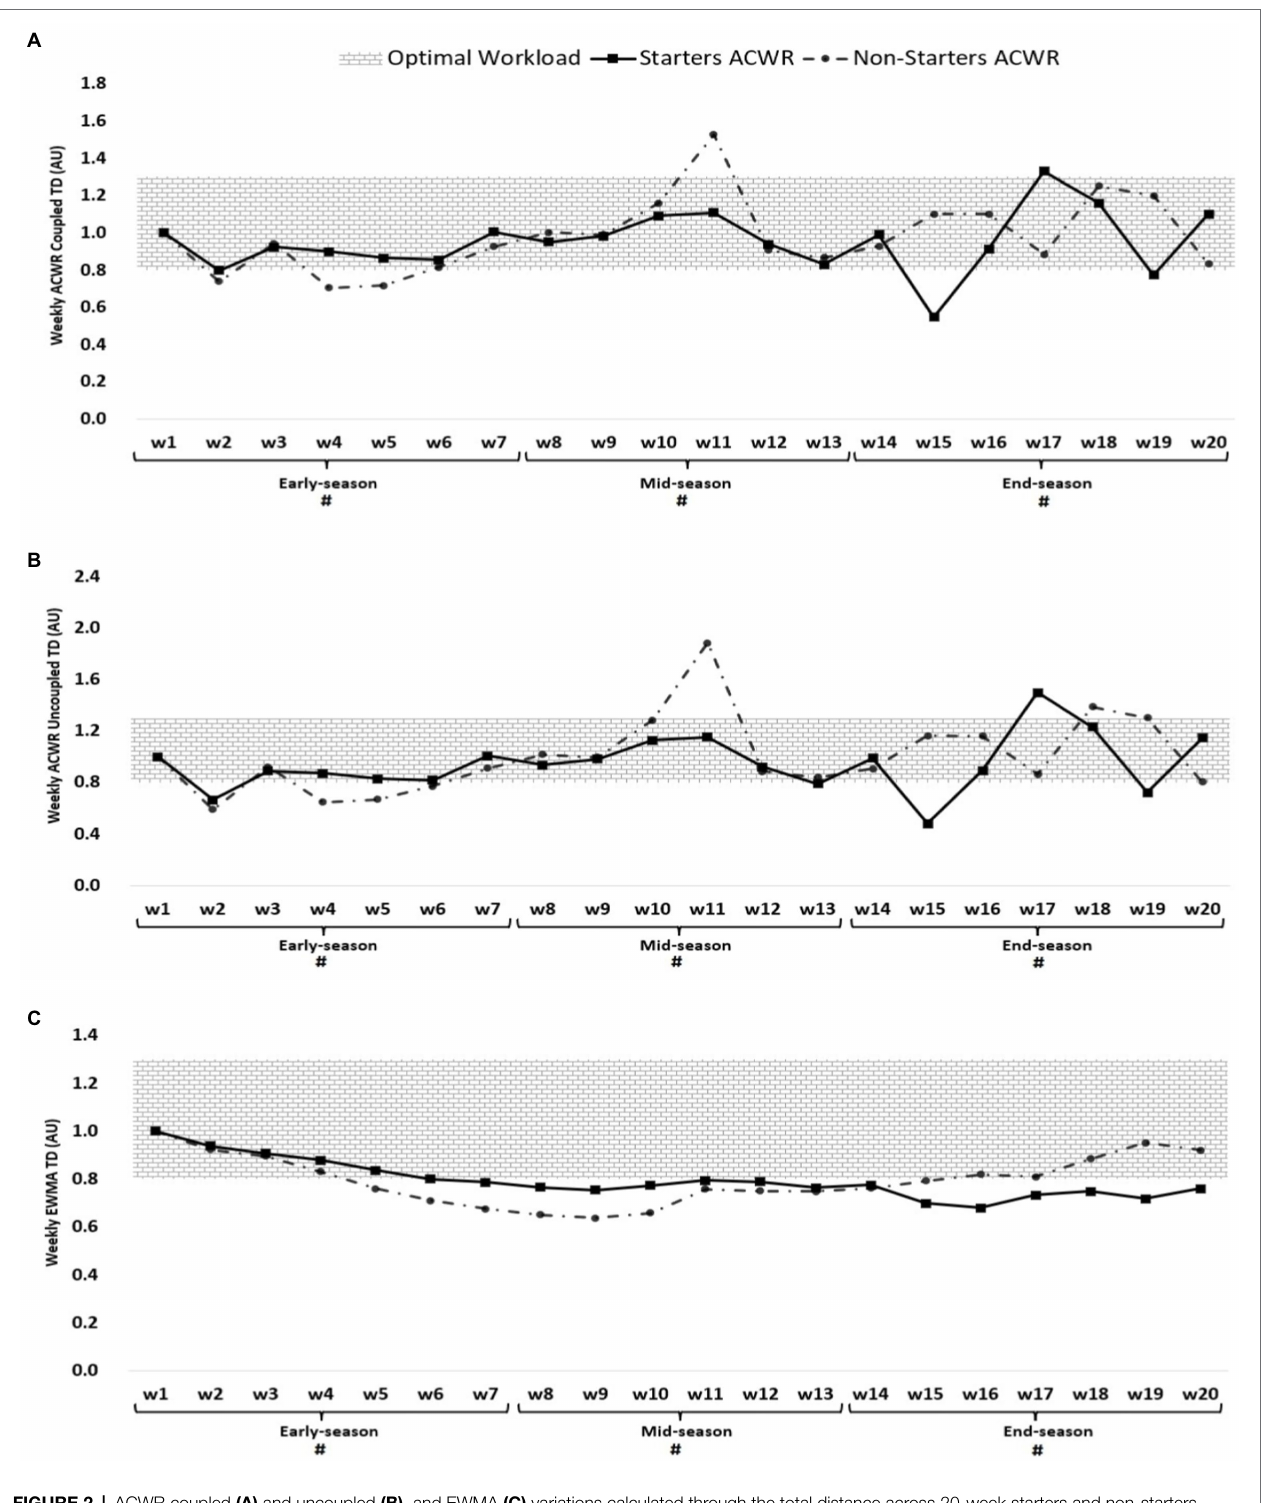
FIGURE 2 | ACWR coupled (A) and uncoupled (B) , and EWMA (C) variations calculated through the total distance across 20-week starters and non-starters. # Denotes significant differences between starters and